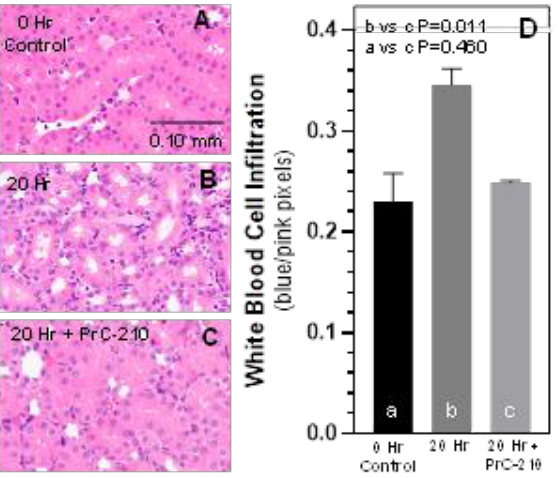
Figure 3. ( A – C ) Kidney histology 20 h following transplant. Operator randomly collected sample images of renal tubules from each of the indicated kidney groups in panels ( A – C ). Then, using an ImageJ macro (see Methods), H/E images (e.g., Figure 3 panels ( A – C )) were analyzed, and above- threshold pink or blue pixels were selected and enumerated, and their ratio was then calculated and plotted to provide an estimate of kidney white blood cell infiltration (Panel ( D )). In Panel ( D ), a,b,c designations are used to enable statistical comparisons between groups.